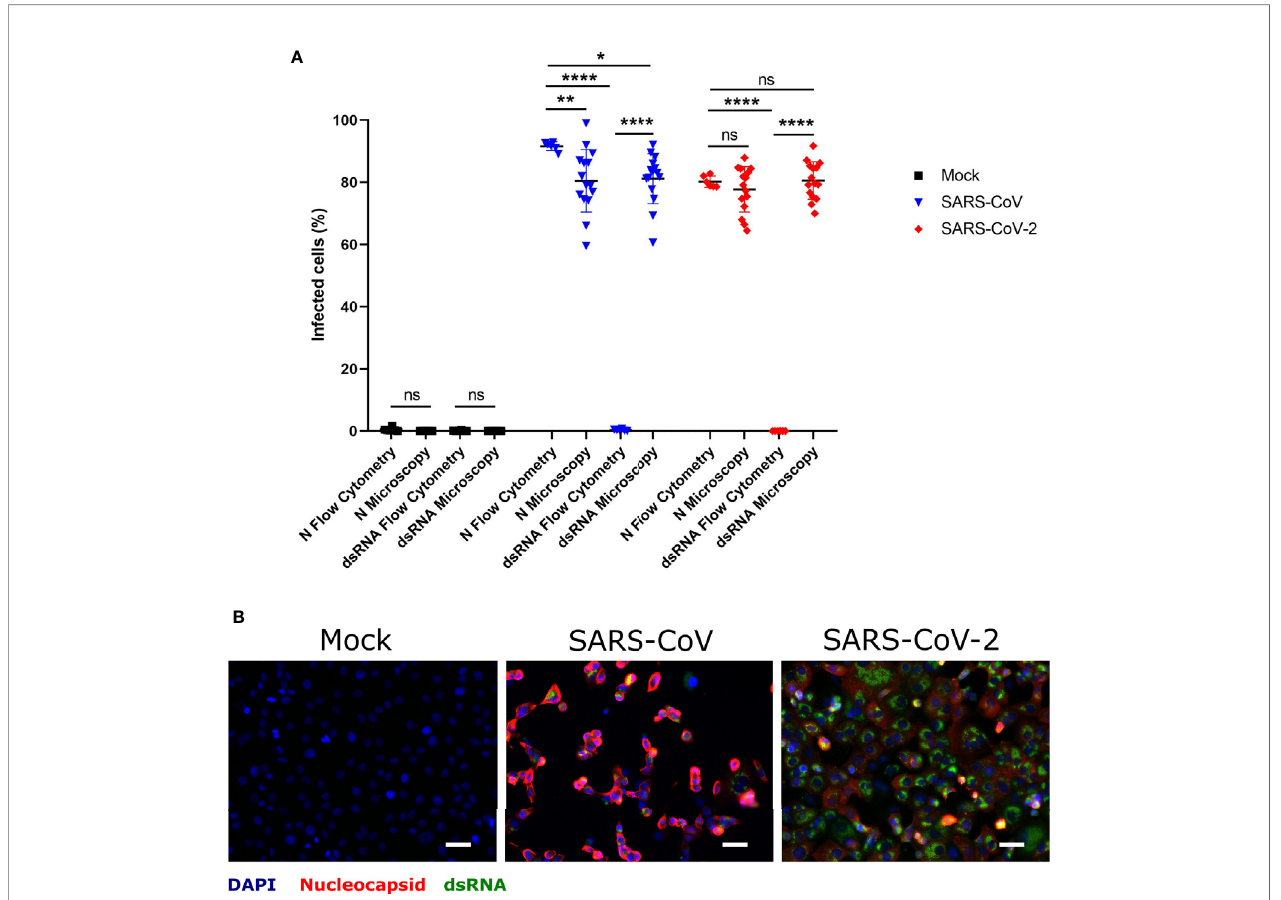
FIGURE 1 | Determination of SARS-CoV and SARS-CoV-2 infected hMDM by immunolabeling for dsRNA and N protein. Vere E6 cells were infected with SARS- CoV and SARS-CoV-2 at MOI 1 TCID 50 /cell, and after 24 hpi dsRNA and N protein were labeled with speci fi c antibodies. The nuclei were stained with DAPI. Then positive cells for dsRNA and N were quanti fi ed either by fl ow cytometry or immuno fl uorescence microscopy (A) . In (B) example of representative images acquired by fl uorescence microscopy is shown. The scale bar represent 40 µm. The data are from three independent experiments. Statistically signi fi cant differences between the conditions are indicated by asterisks (ns indicates non-statistical differences, *p < 0.05, **p ≤ 0.002 and ****p ≤